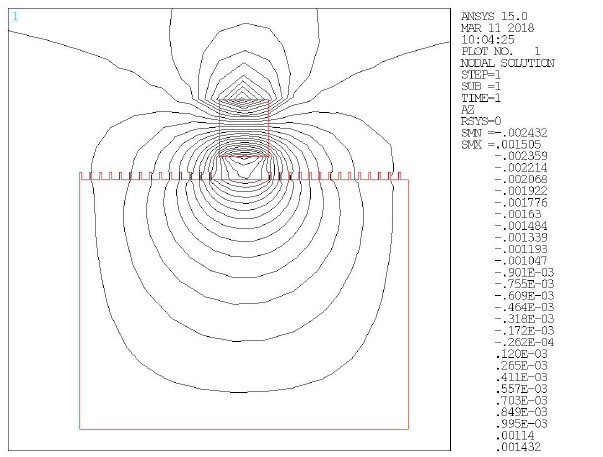
Fig. 8 The distribution of magnetic field lines when ordinary sealant is used to bond the split pole shoes. there is no magnetic field distribution at pole tooth which is farther from magnet. This suggests that when split pole shoes are bonded by ordinary sealant, the thin sealant is not magnetically permeable, only equivalent to a magnetically shielded ring that is perpendicular to magnetic field direction and is as thick as pole shoe width. Thereby, the magnetic field intensity at the junction gap between sealant and pole tooth is reduced to a large extent.